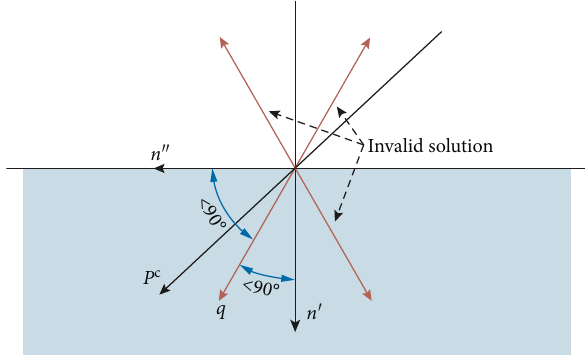
Figure 9: The selection of the iterative initial